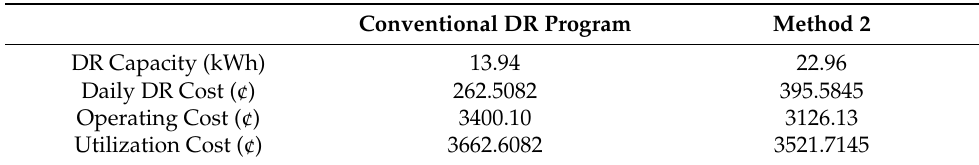
Table 3. Comparison of the DR programs.